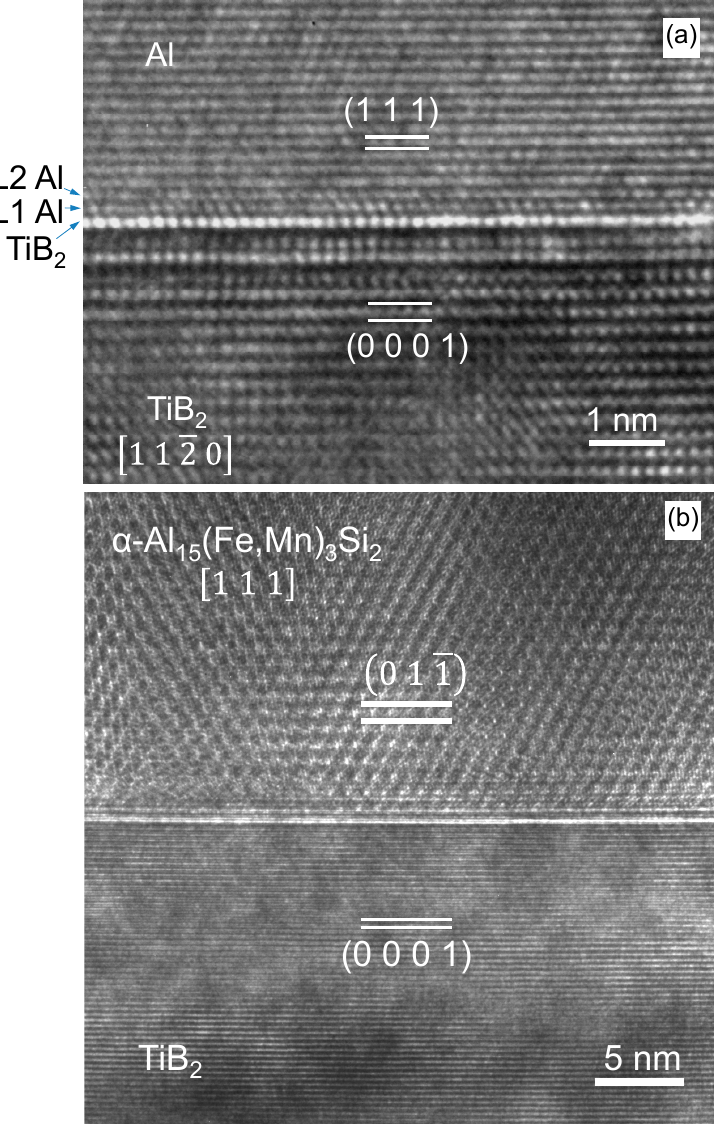
Figure 10. High resolution TEM micrographs show that, on the (0001) TiB 2 substrate, there exists an epitaxial first layer and a twist of the nucleated crystals relative to the substrate. ( a ) α -Al phase and ( b ) α -Al 15 (Fe, Mn) 3 Si 2 phase nucleated on the (0001) TiB 2 substrate showing a 4.7° and 4.5° twist relative to the TiB 2 substrate, respectively. The observed twist angles are in good agreement with the results from MD simulations (Figure 8b), providing an experimental support to the proposed nucleation mechanism (Figure 9).